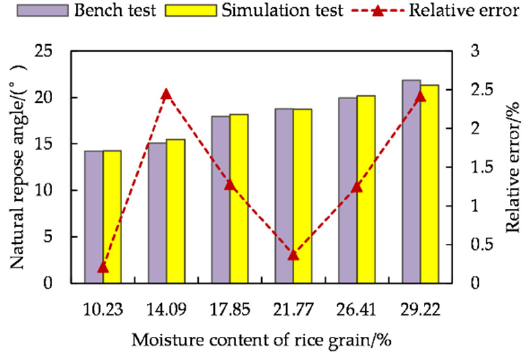
Figure 1. Natural rest angle of rice seeds with different moisture content.